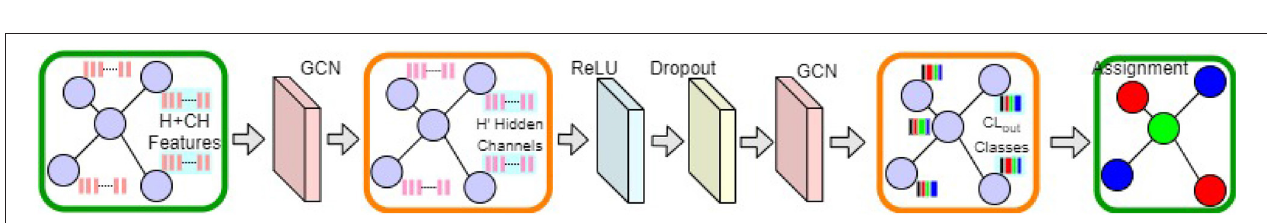
FIGURE 4 | Left : Segmented vessels. Middle-left : A zoomed-in segmented vessel segment. Middle-right : Graph representation with vessel (gray circles) and background (white circles) nodes; graph edges are built following the segmented vessel segment. Right : Each node (for both connected vessel nodes and isolated background nodes) is associated with the x features and is mapped to the y label.